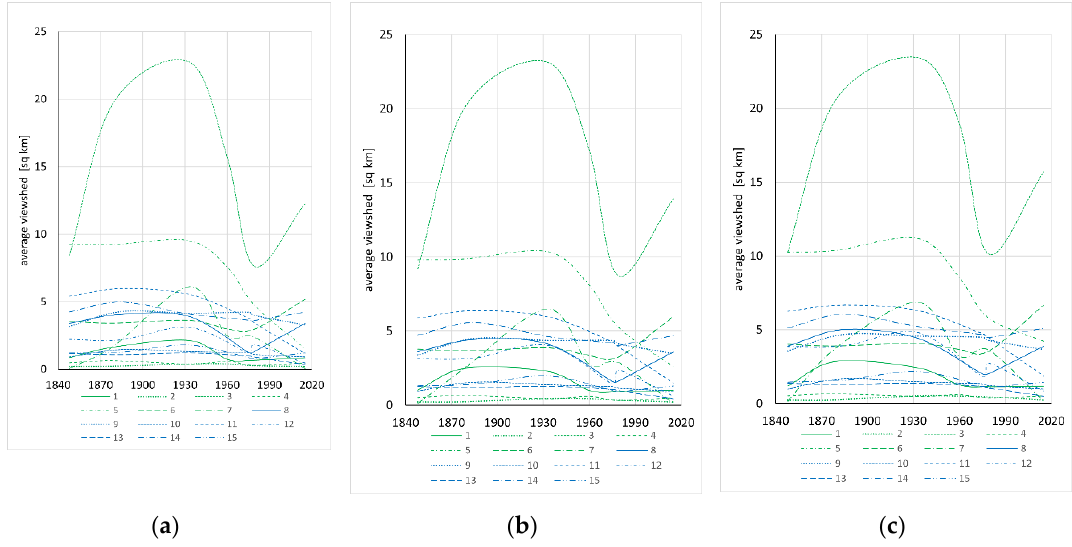
Figure 5. Changes in average of viewshed from viewpoints located at different altitudes above ground level: ( a ) 1.5 m; ( b ) 3.0 m; ( c ) 4.5 m. 1 – 15 — numbers of glades — see Table 1.